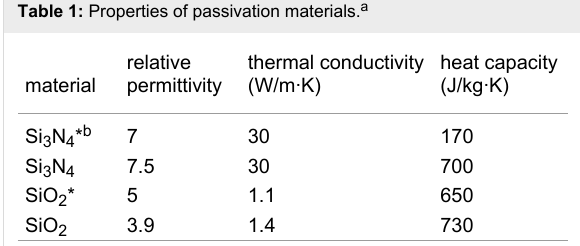
Table 1: Properties of passivation materials. a